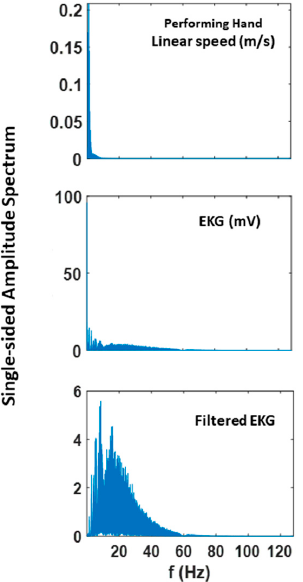
Figure A1. Fourier power spectrum of linear speed and EKG and filtered EKG signals extracted from 60 trials of pointing motion (i.e., 300 s).